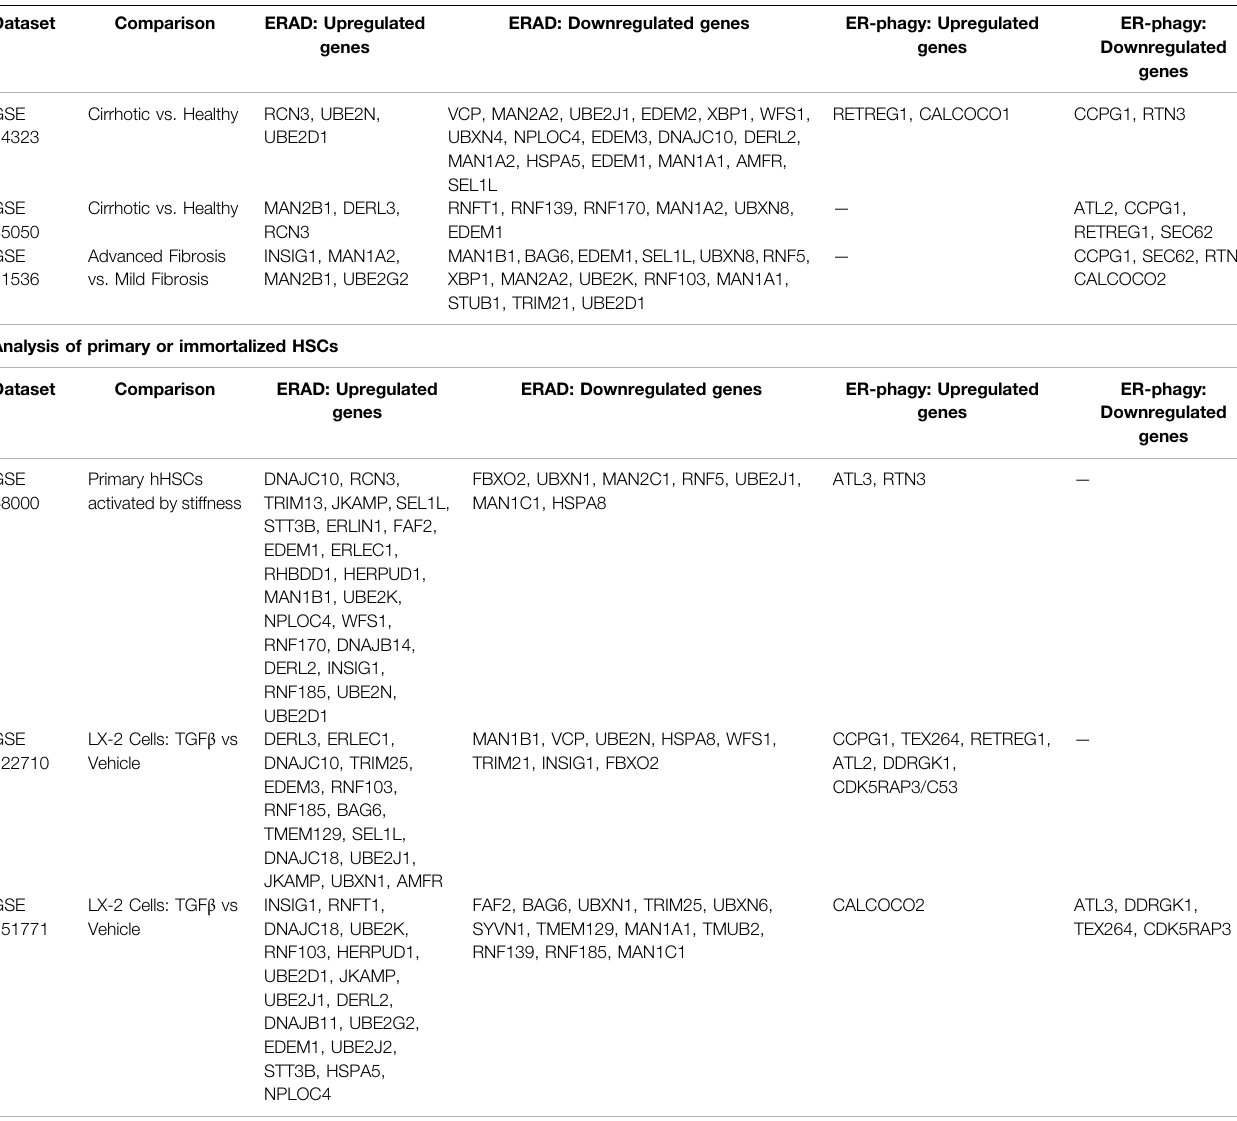
TABLE 3 | RNAseq Analyses of Cirrhotic livers or Hepatic Stellate